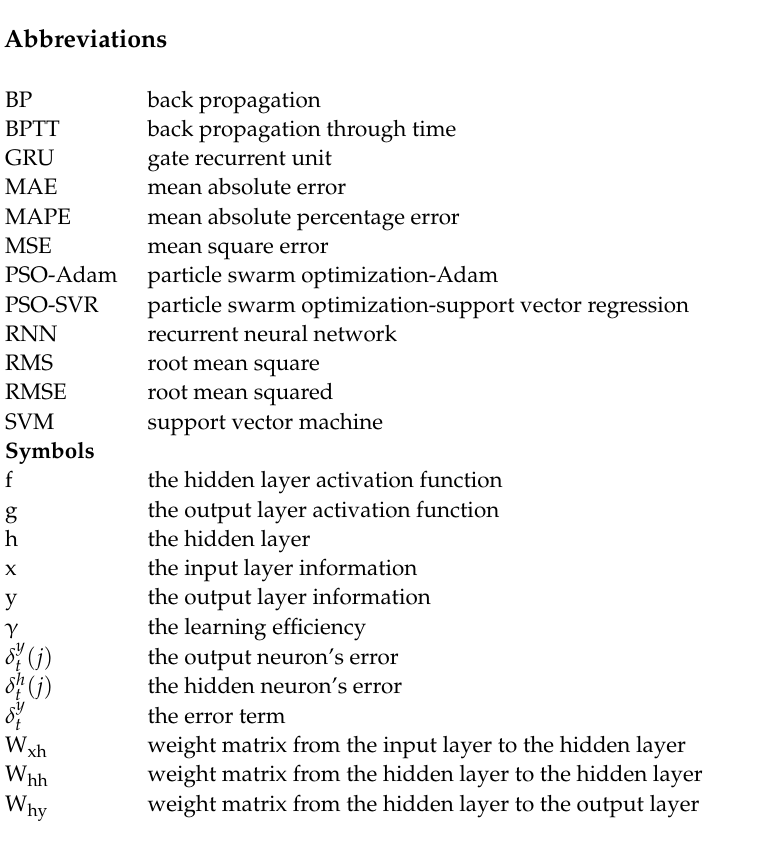
The RNN gas concentration prediction method and parameter optimization method based on Adam optimization can effectively predict gas concentration. Compared with the traditional BP neural network and the SVR method, the RNN method had higher accuracy and, at the same time had better robustness and applicability in terms of prediction stability. Therefore, this method has higher accuracy and could provide guidance for mine gas